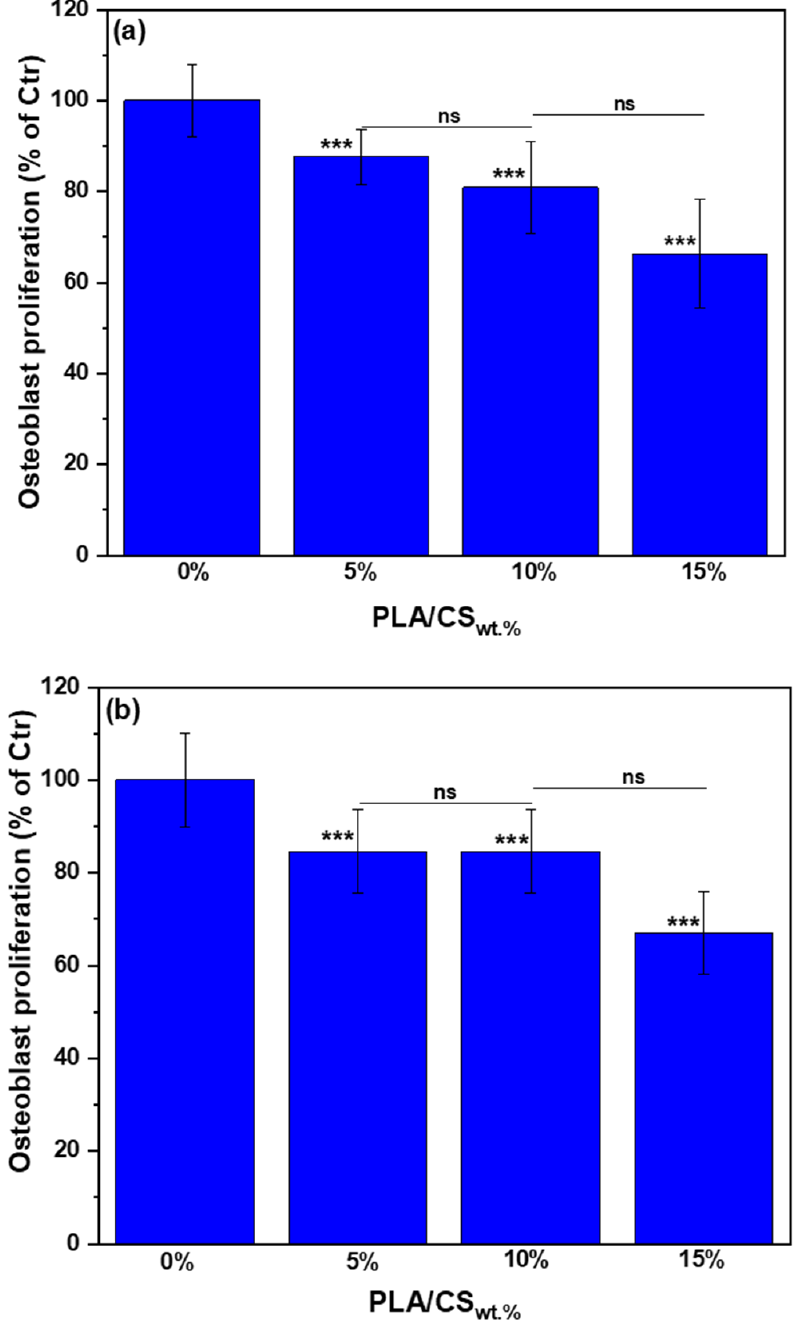
Figure 9. Osteoblast cells proliferation after 3 days ( a ) and 5 days ( b ) for pure PLA (Control, Ctr) and PLA/CS porous scaffolds at different CS contents. (*** p ˂ 0.001; ns = not significant).